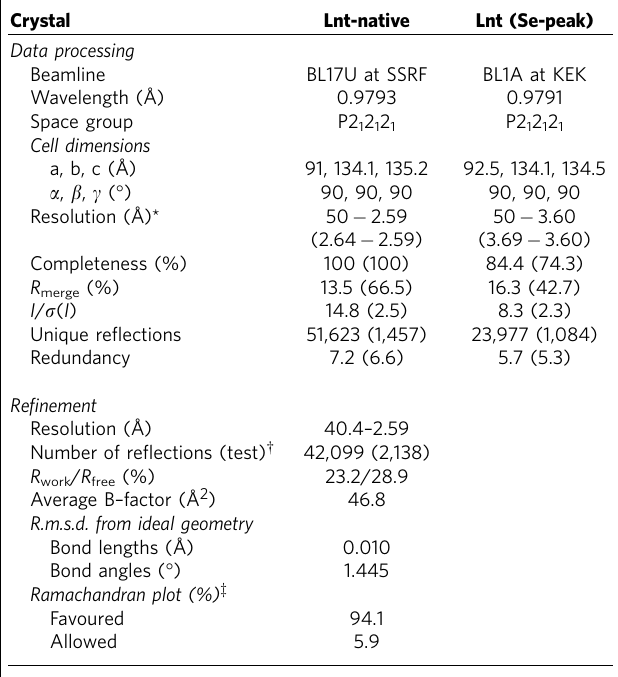
Table 1 | Statistics of data collection and refinement.